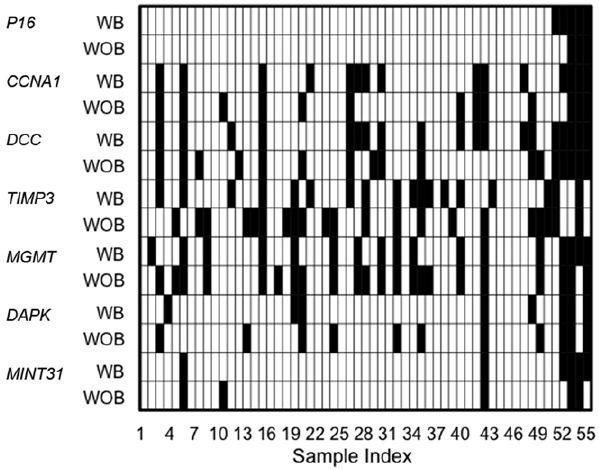
Figure 1. Aberrant promoter methylation in the DNAs from salivary rinses collected with or without an exfoliating brush from 57 HNSCC cancer patients. Each column represents a patient, and each row the methylation status of the given gene in salivary samples collected with brush or without brush. Black shading indicates promoter hypermethylation and white indicates lack of promoter methylation. WB, salivary rinses collected with an exfoliating brush; WOB, salivary rinses collected without